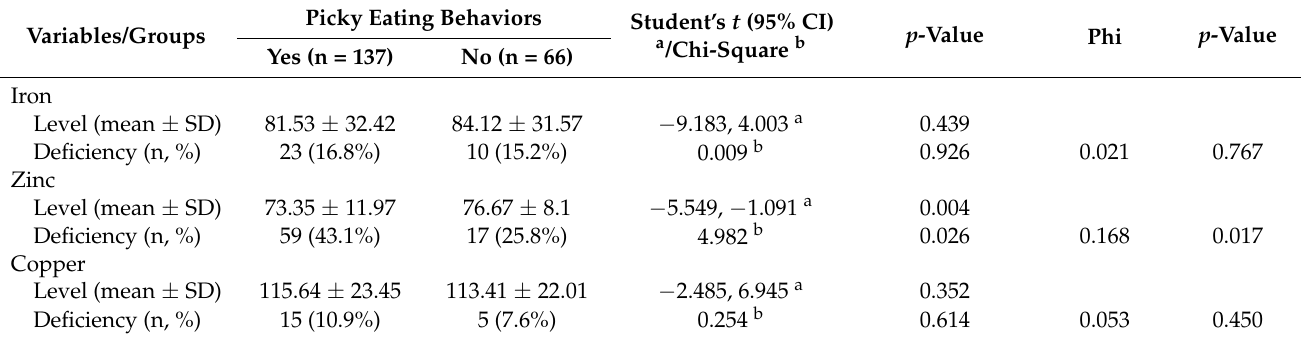
Table 3. Correlation of trace element levels and deficiency with picky eating behaviors.